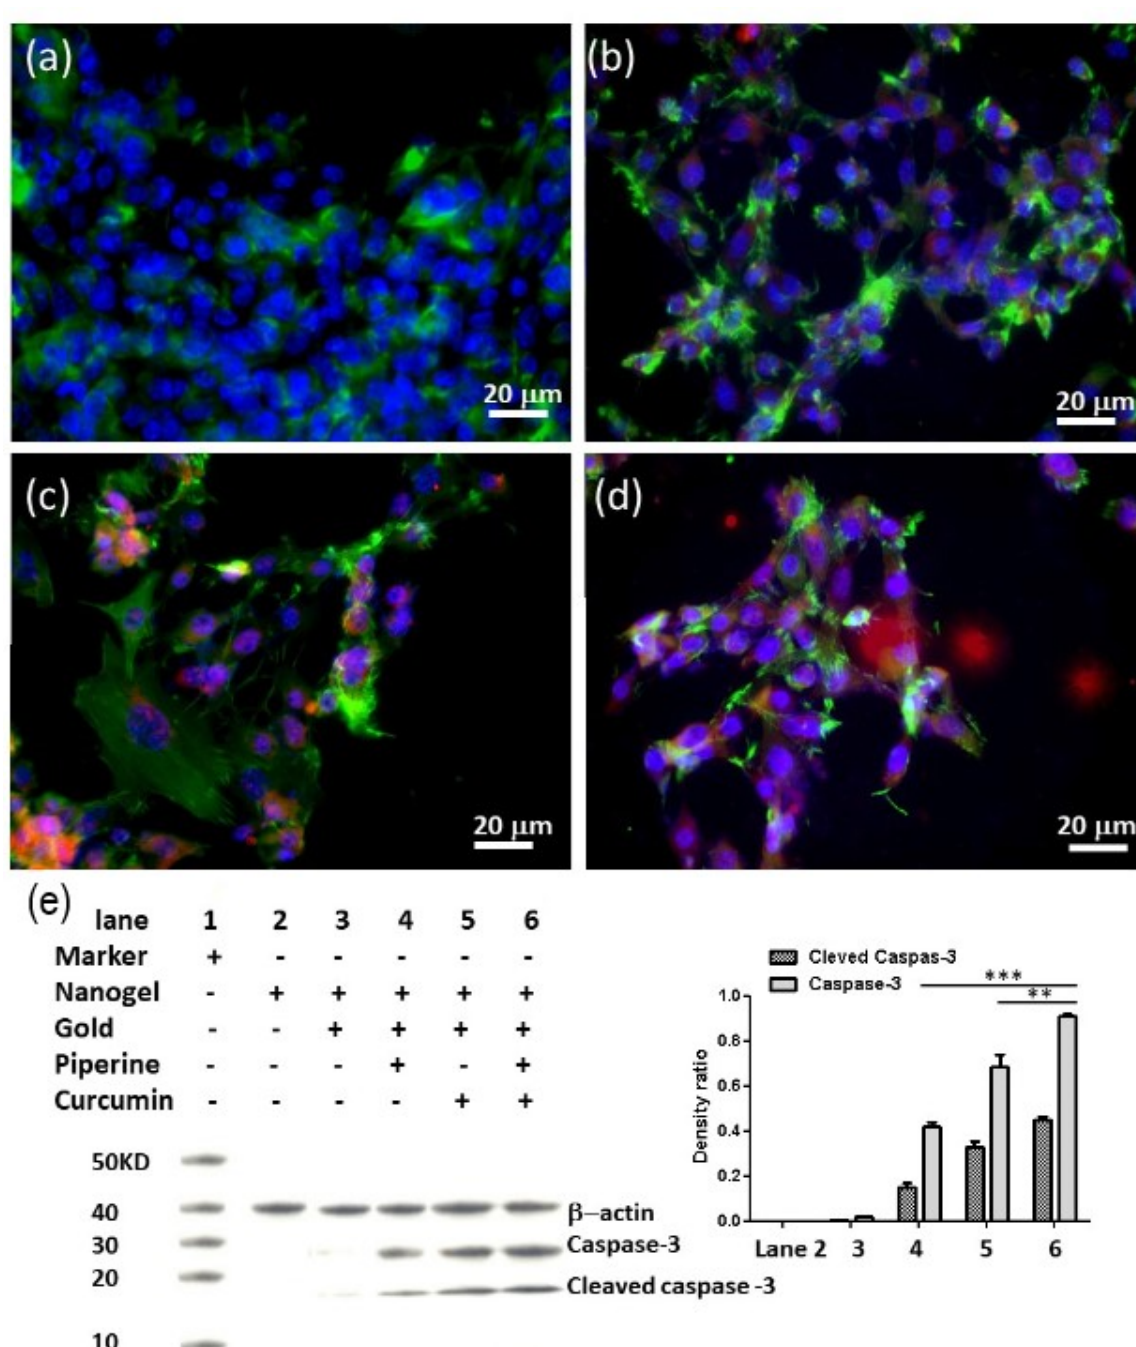
Figure 5. Immunoblotting of U-251 MG cells under nanogel treatment. Laser scanning microscopy images show U-251 MG cells treated with ( a ) nanogel, ( b ) piperine-loaded nanogel, ( c ) curcumin-loaded nanogel, ( d ) curcumin–piperine-loaded nanogel after 72 hours at 21 μ M concentration. ( e ) Western blot and histogram of density ratio of caspase-3/ β -Actin and density ratio of cleaved caspase-3/ β -Actin. (** p < 0.01, *** p < 0.001). Color code: Caspase-3: Red; F-actin: Green; Cell nuclei: Blue.